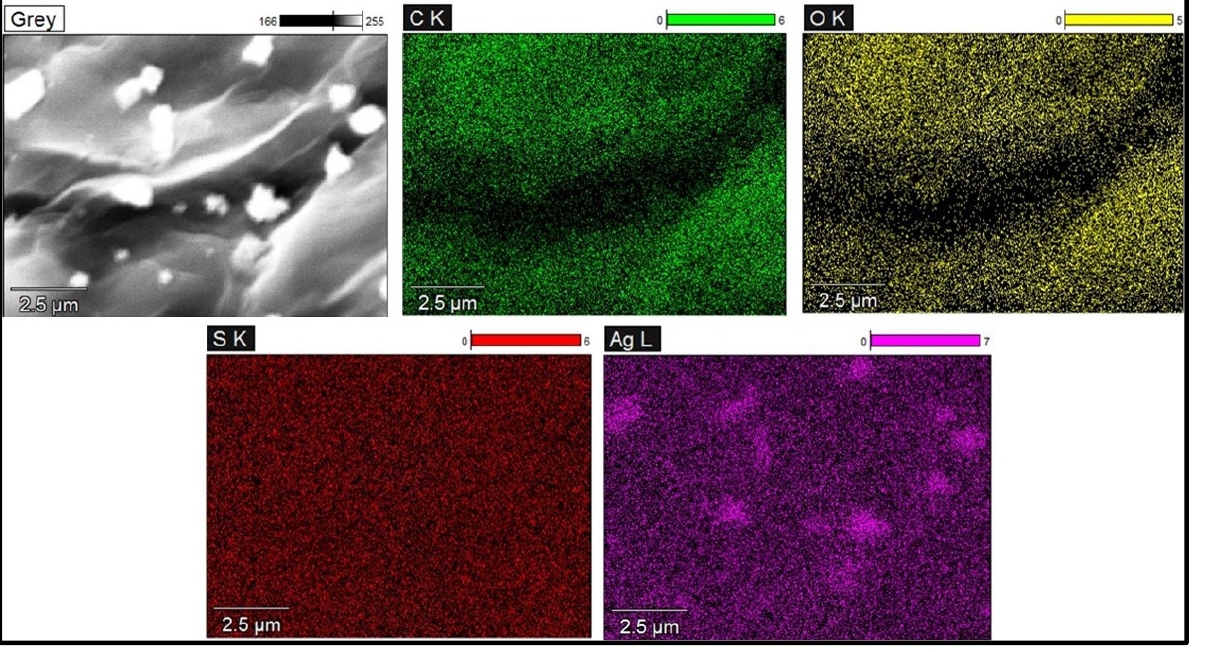
Figure 4. STEM elemental mapping of Ag NPs@GO-FL-CS 300.